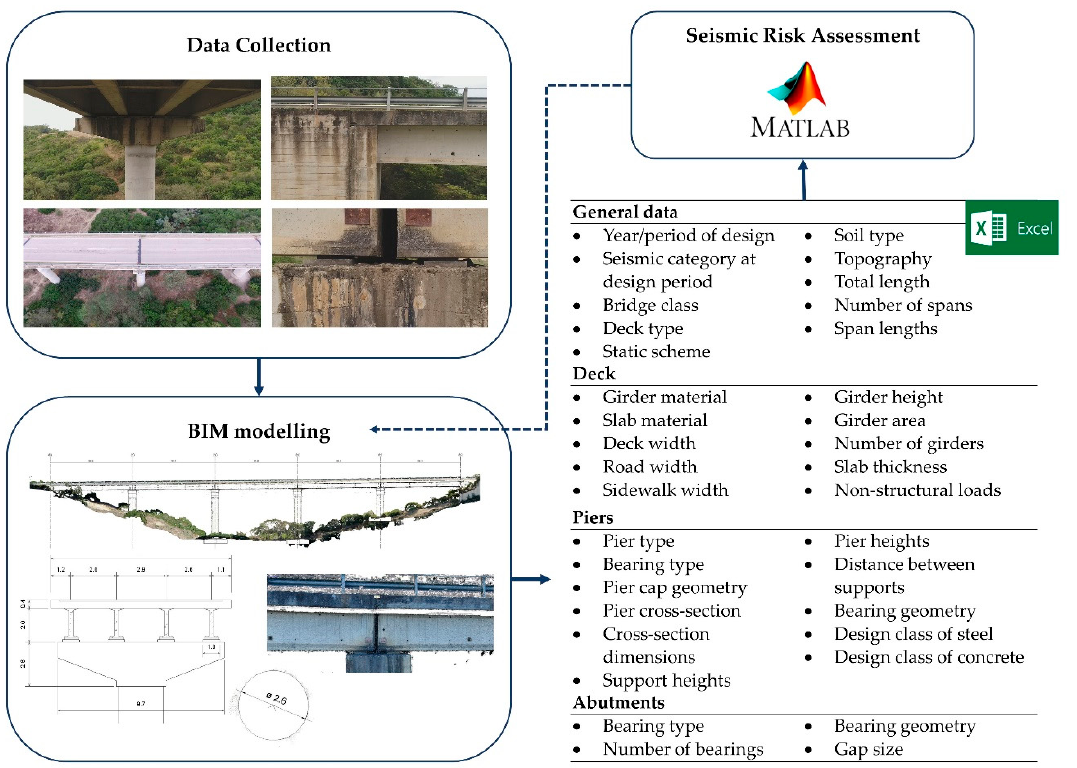
Figure 8. Sequence of steps for the geometry extraction and allocation of data in BIM and Excel spreadsheet to perform the seismic risk assessment. A list of the data necessary for the risk calculation is indicated.